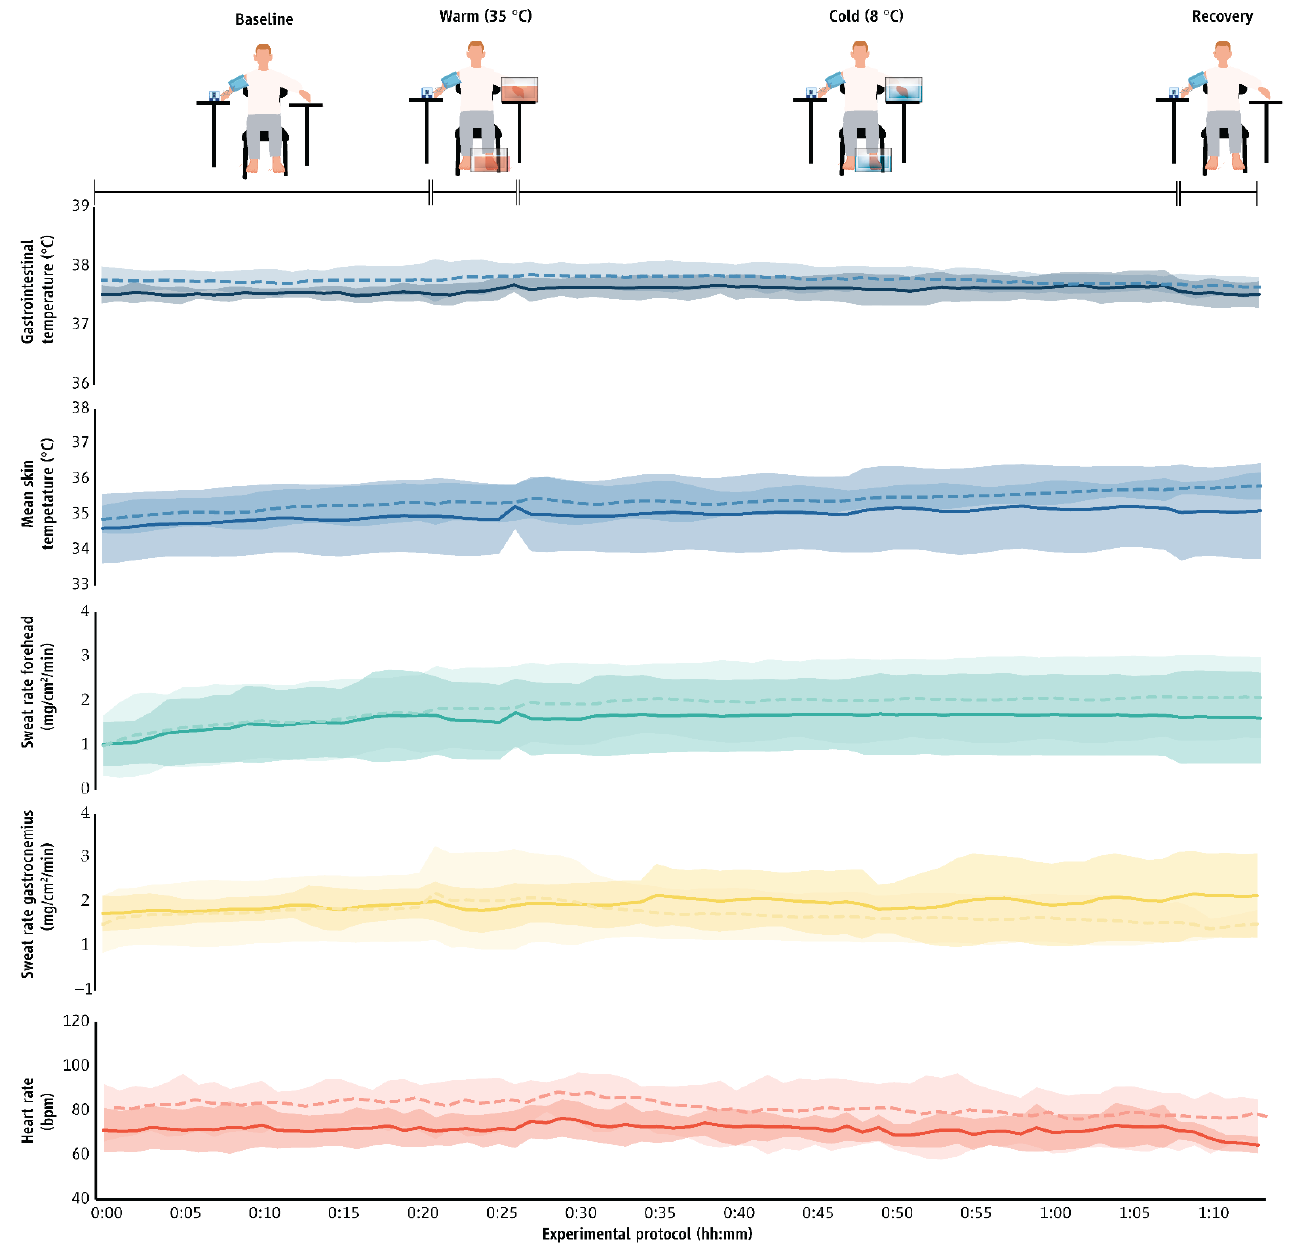
Figure A5. Physiological parameters (mean ± SD) during exposure to the hot environment (34 ± 1 °C) in the two groups. The first 20 min (00:00 to 00:20) indicate data collected during the baseline phase, the next five min (00:20 to 00:25) indicate responses during the warm-water immersion, the next 40 min (00:30 to 00:70) indicate responses during the cold-water immersion, and the final five min (00:70 to 00:75) show responses during the recovery phase. Continuous yellow lines indicate results for men participants and with dashed yellow lines present results for the women individuals.